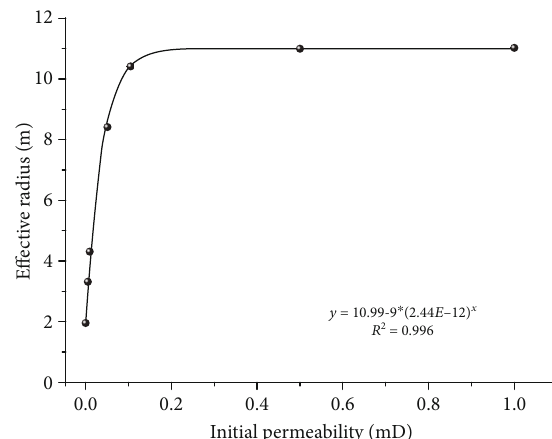
Figure 9: Relationship between extraction time and e ff ective radius.